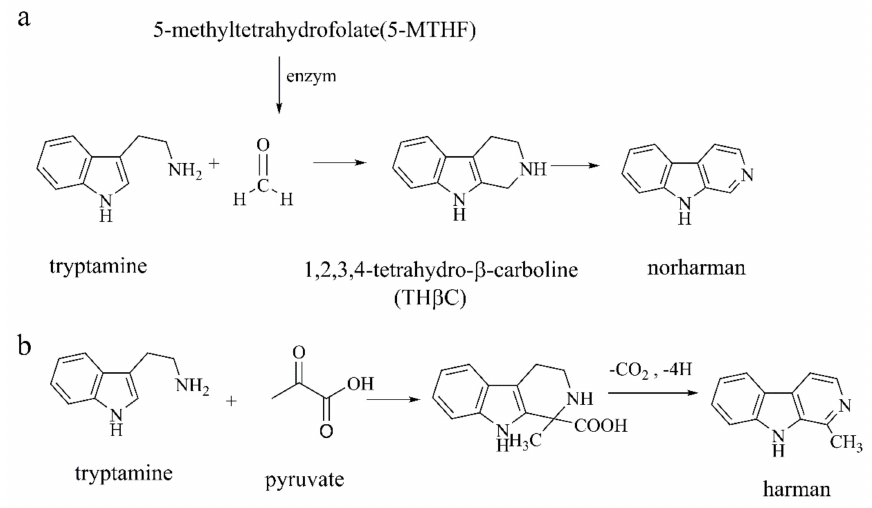
Figure 10. ( a ) The biosynthesis of norharman [77]; ( b ) the biosynthesis of harman [77]. TaClo